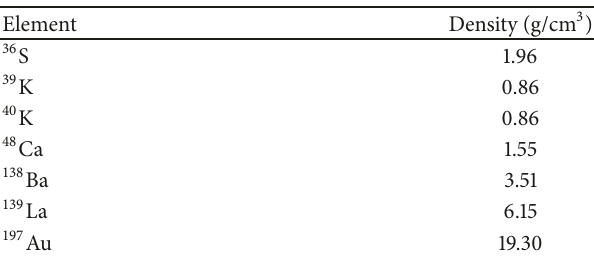
Table 2: Selected isotopes and their